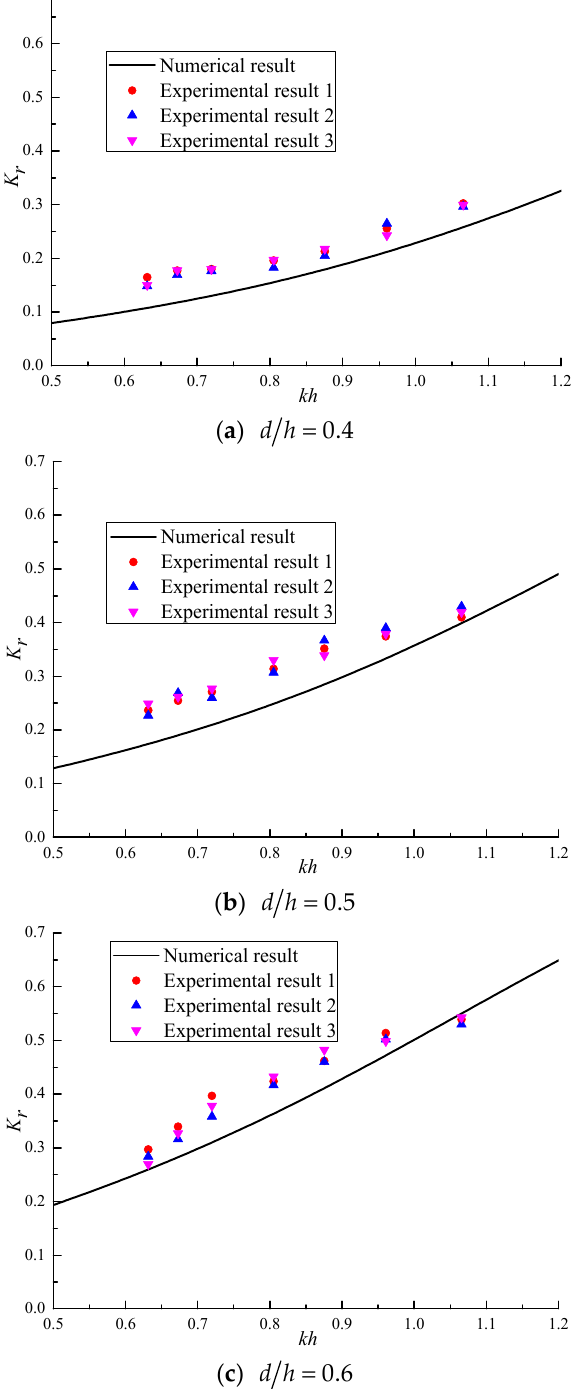
Figure 11. Comparisons of the numerical and experimental reflection coefficients ( N = 1).